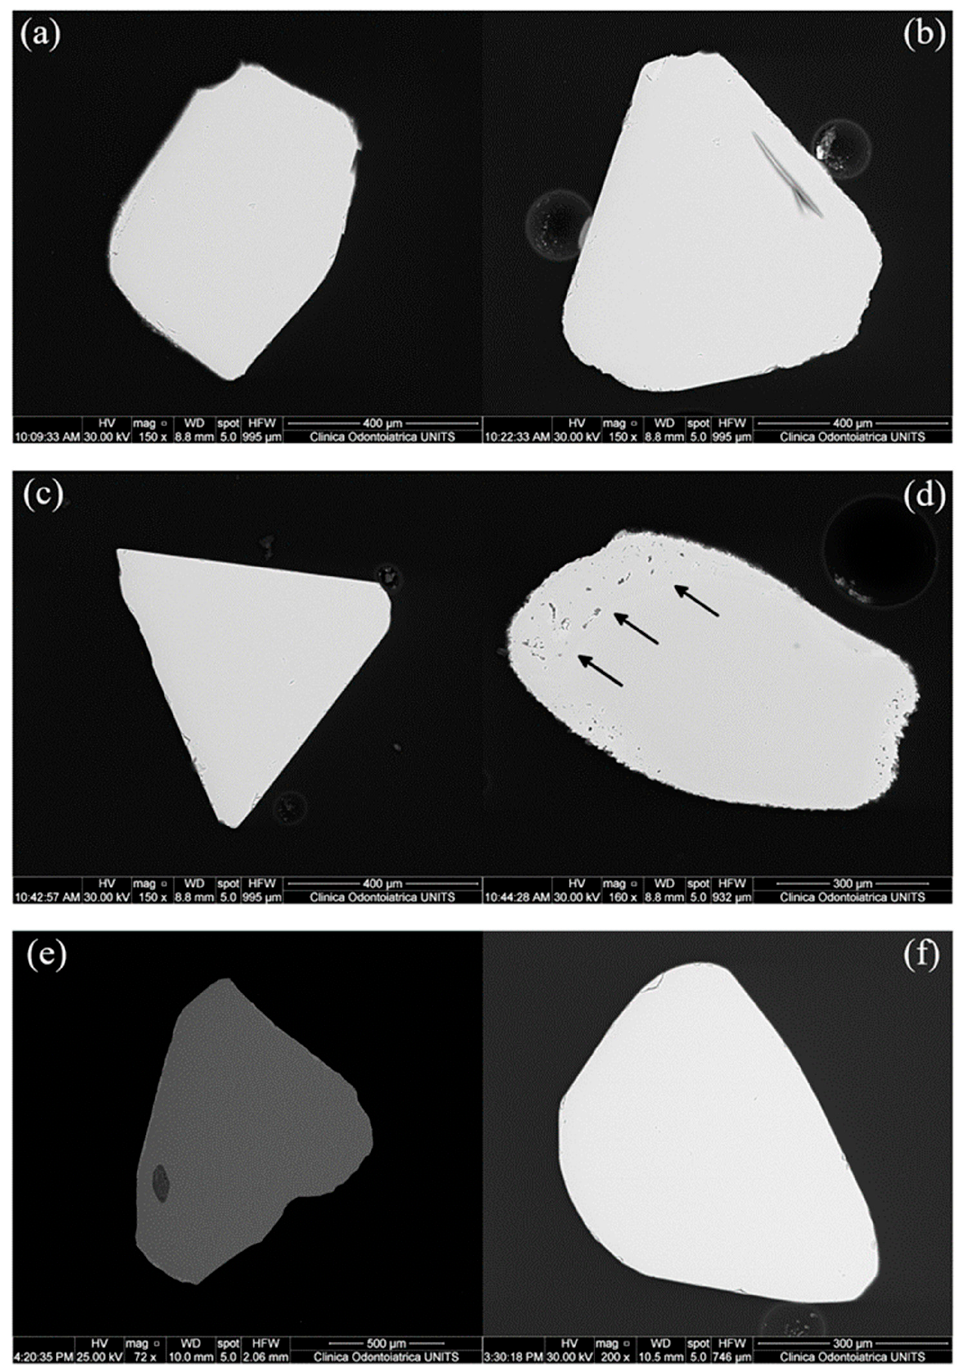
Figure 1. Backscattered electron images (BSE) of the Cr-spinels. ( a ) (M2_14) and ( b ) (M2_23) Cr-spinels from Mir pipe; ( c ) (M2_36) and ( d ) (M2_37) Cr-spinels from International ‘naya, arrows indicate the rim; ( e ) (M1_09) Cr-spinel from Aikhal with a large polymineralic inclusion; ( f ) (M4_08) Cr-spinel from Komsomolskaya .